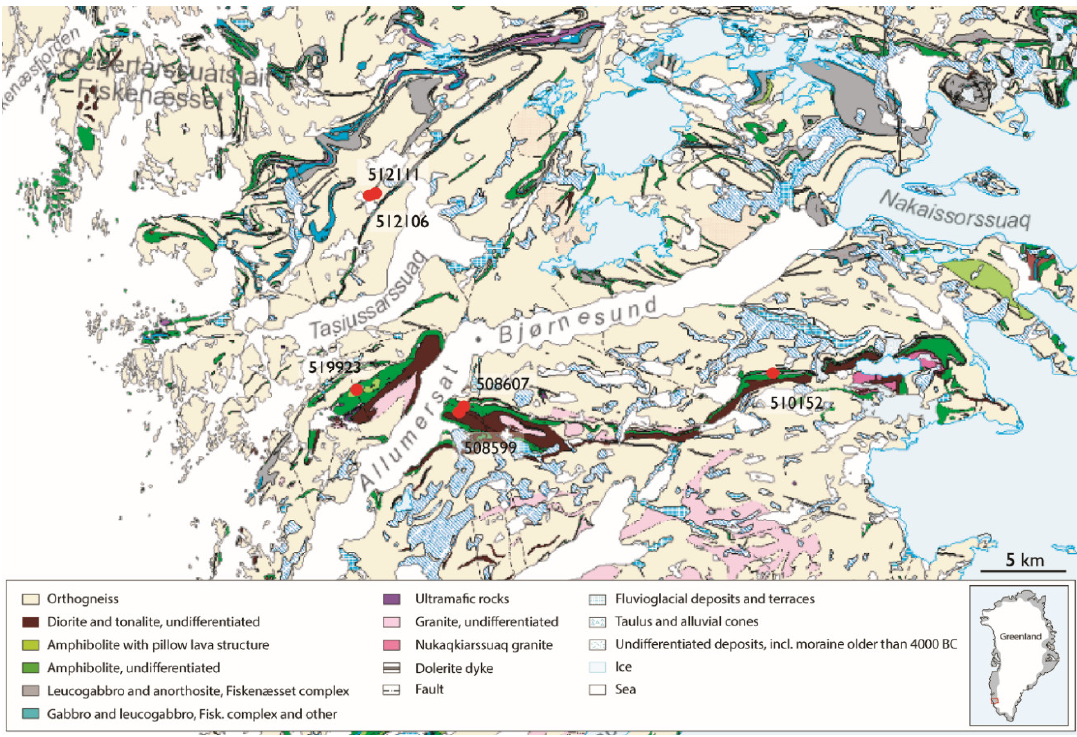
Figure 1. Geological map of southern West-Greenland near the village Fiskenæsset. The localities of the samples used in this study are indicated with red dots. Map modified from GEUS [40].